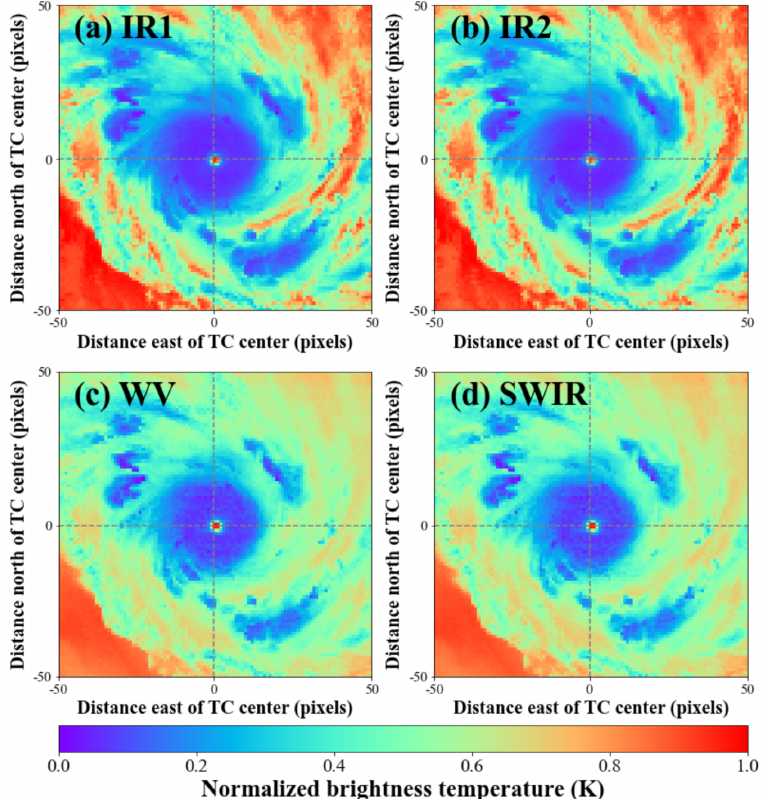
Figure 1. Examples of normalized brightness temperature images of a radius of about 600 km from the center of Typhoon Meranti (1614) extracted from the ( a ) infrared 1 (IR1), ( b ) infrared 2 (IR2), ( c ) water vapor (WV), and ( d ) short-wavelength infrared (SWIR) channels of the COMS Meteorological Imager. The images were obtained at 12:00 UTC on September 13, 2016 (location: 123.0923 ◦ E, 20.3716 ◦ N). The axis units are pixels (1 pixel = ~12